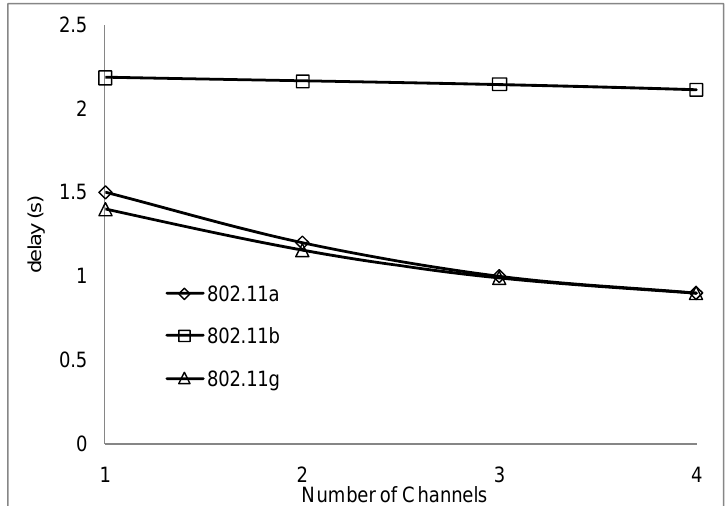
Figure 23. Delay occur at 100 m range and data rate of 54